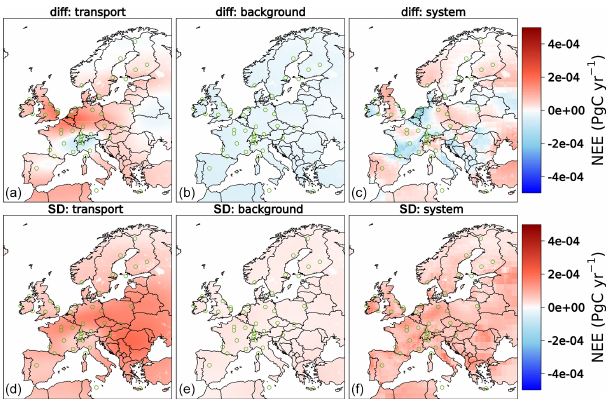
Figure 4. Panels (a) – (c) indicate differences in annual posterior NEE estimated with STILT and FLEXPART models, referred to as “transport” (CS3-CF3); TM3 and TM5 are referred to as “back- ground” (CS3-CS5); and CSR and LUMIA are referred to as “sys- tem” (CF3-LF3). Panels (d) – (f) demonstrate the standard deviations of the corresponding monthly differences.